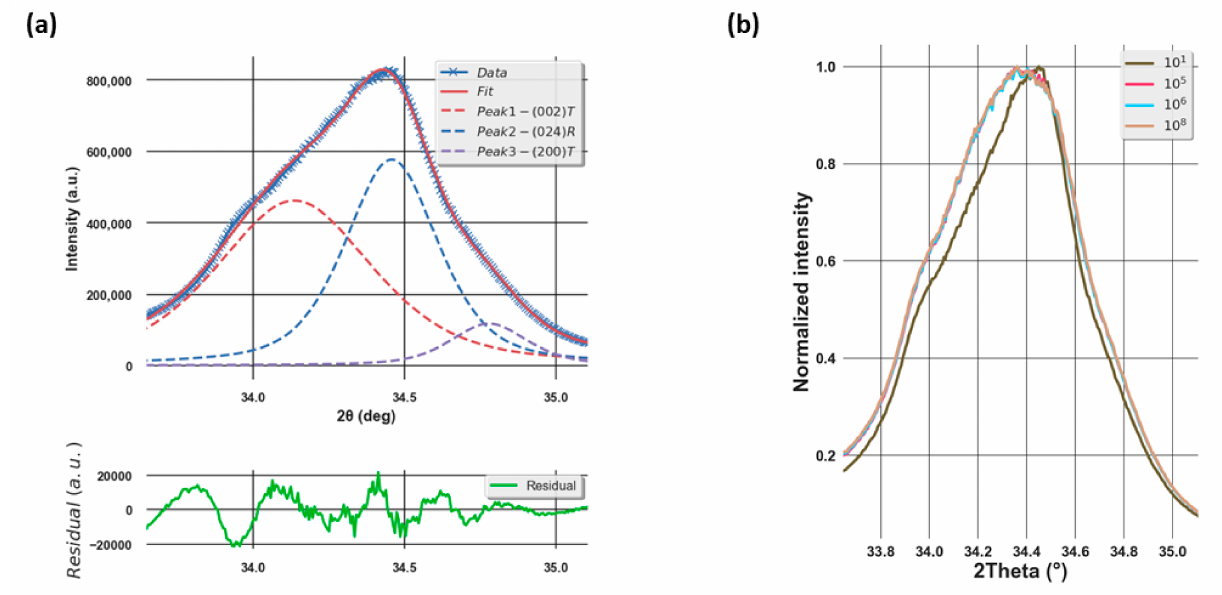
Figure 2. ( a ) XRD peak profile measured at the zero field and ( b ) the comparison of the peak profile from one up to 10 8 electric cycles. ( b ) The XRD peak profile from the sample after one, 10 5 , 10 6 , and 10 8 electric cycles. These are the peaks obtained at the zero field immediately after the AC cycling. It can be seen that after 10 8 cycles, the intensity of the peak (002)T increases in comparison with that at one cycle at the expense of the (024)R